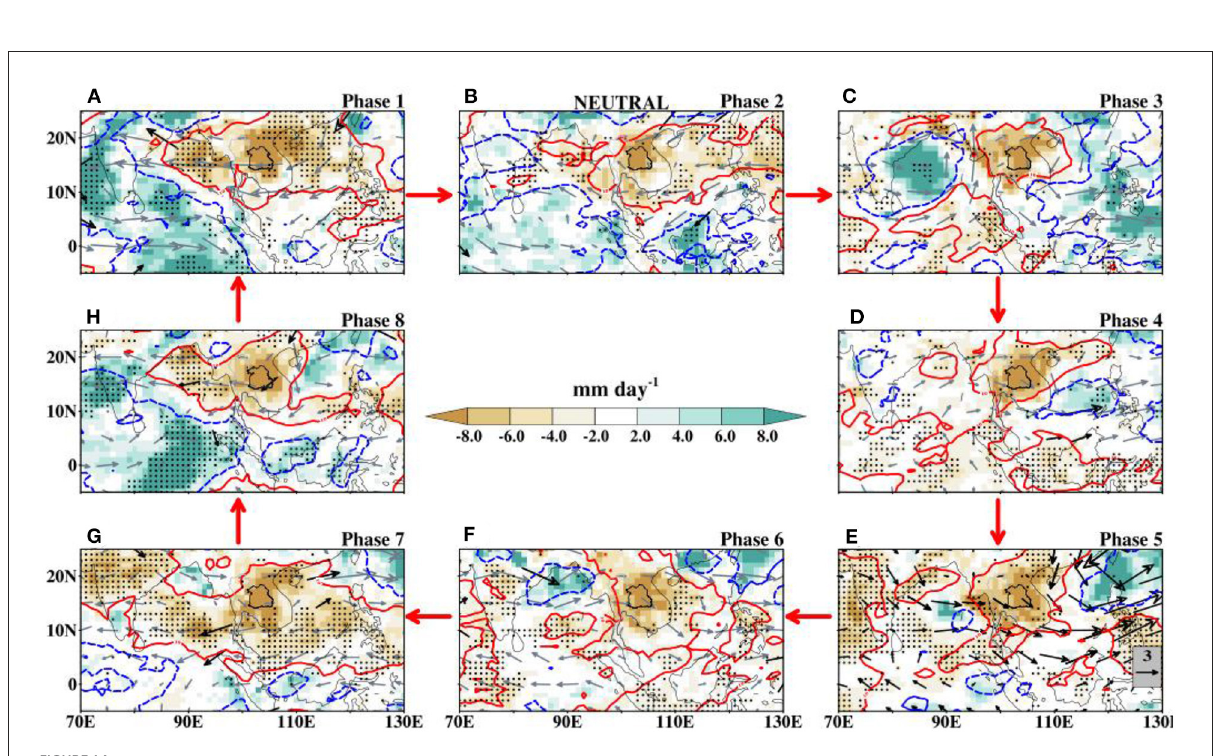
FIGURE14 (A–H) Same as Figure 12 but for Neutral and active BSISO